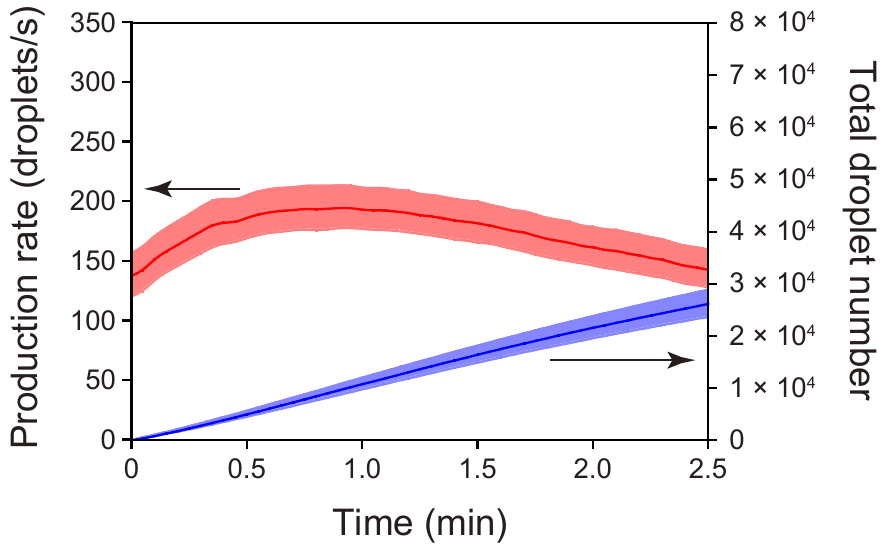
Figure 5. Time-course changes in the droplet-production rate and total droplet number for the PET/PDMS microchip (Variant I). The red line shows the mean droplet-production rate. The blue line shows the mean total number of droplets produced, which was calculated by integrat- ing the production rate with respect to time. The colored, shaded areas above and below the lines represent ± 1 standard error of the mean. The number of runs ( n ) =